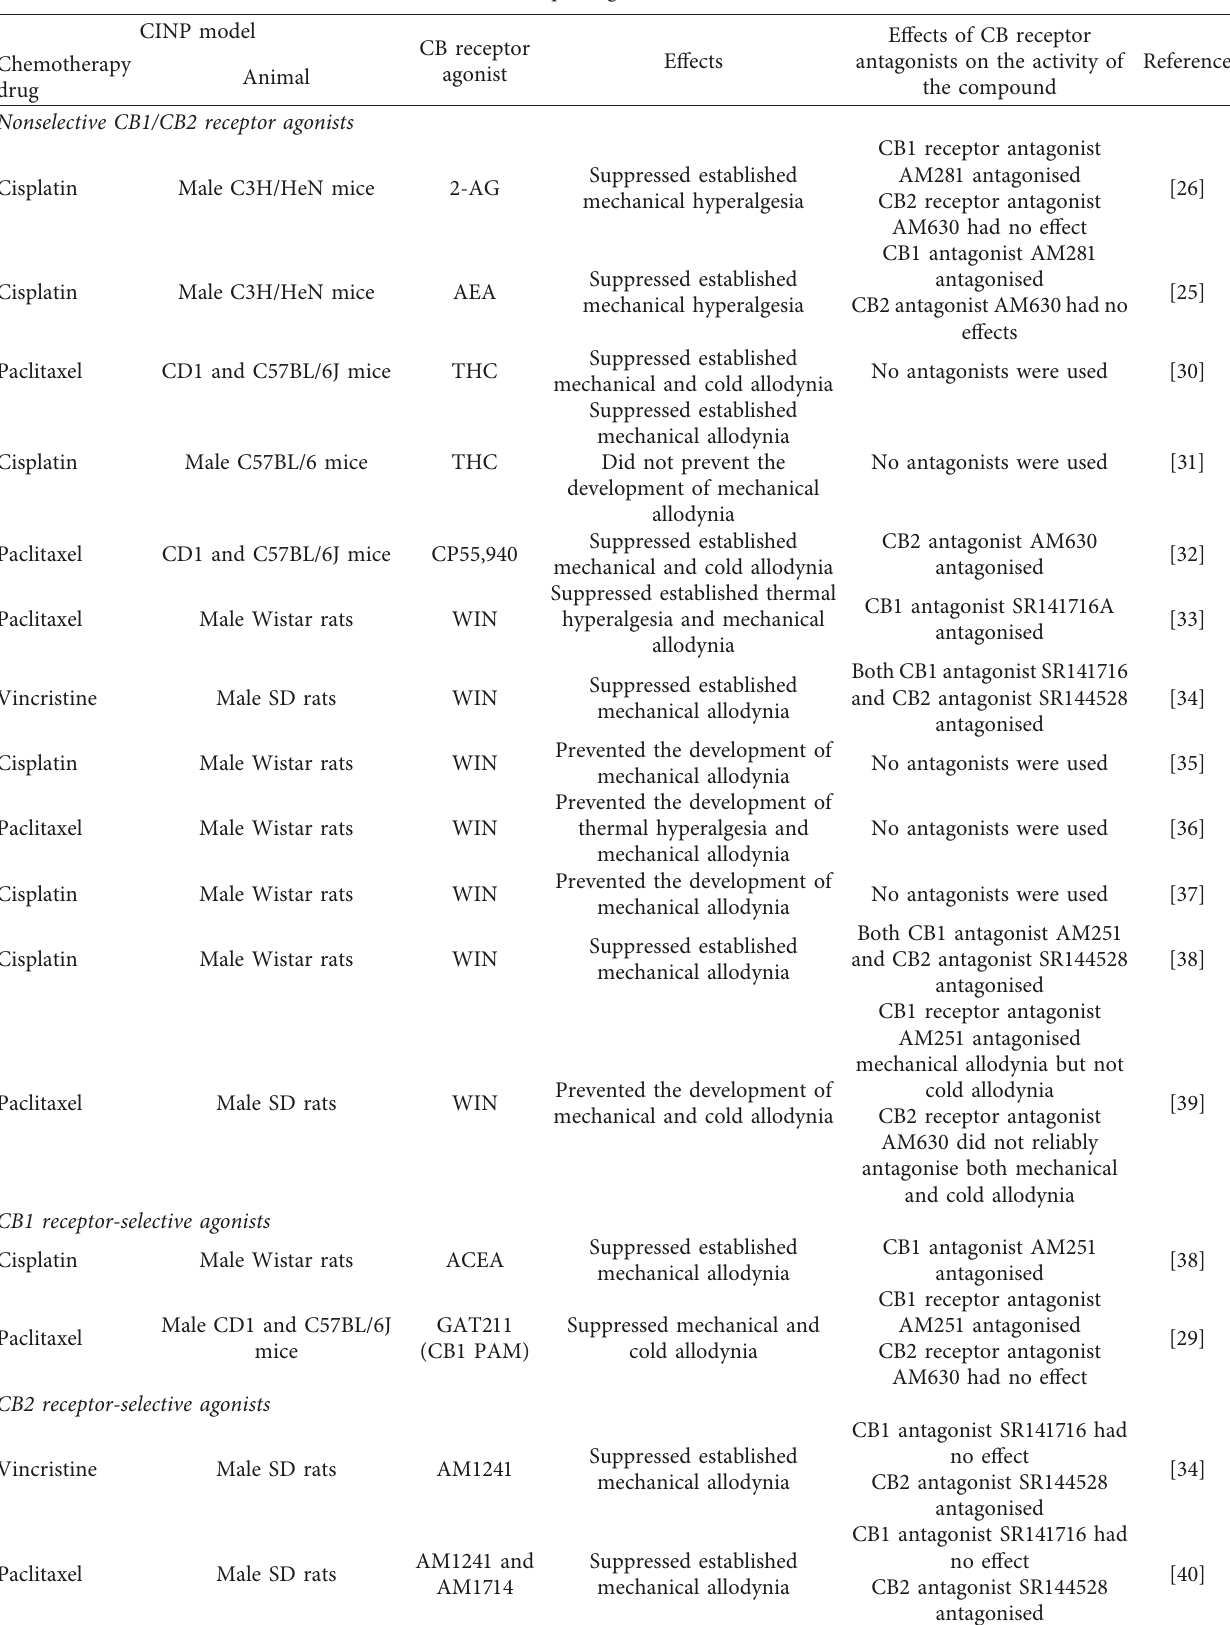
Table 3: Effects of CB receptor agonists in animal models of